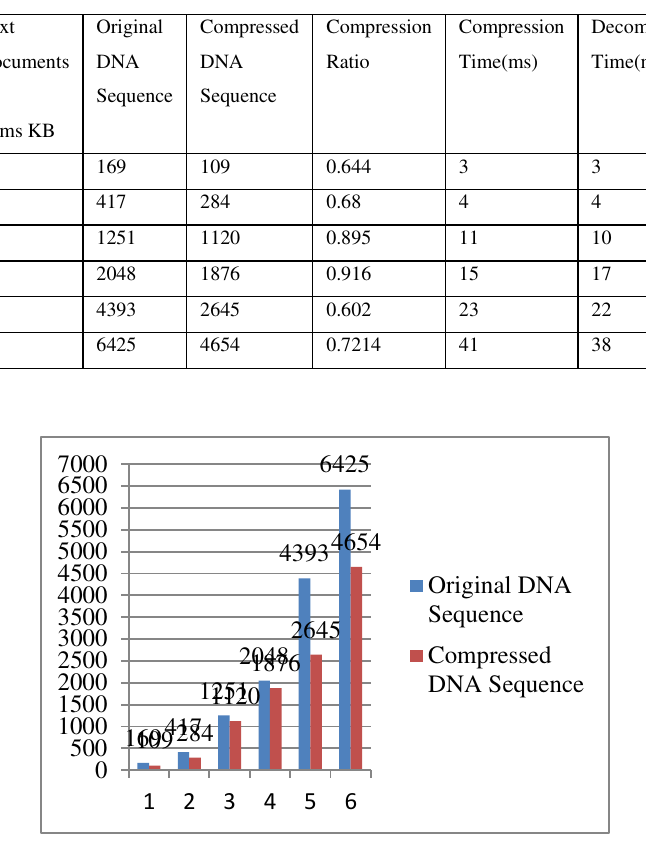
Table 1. Performance Measurement for Compression and